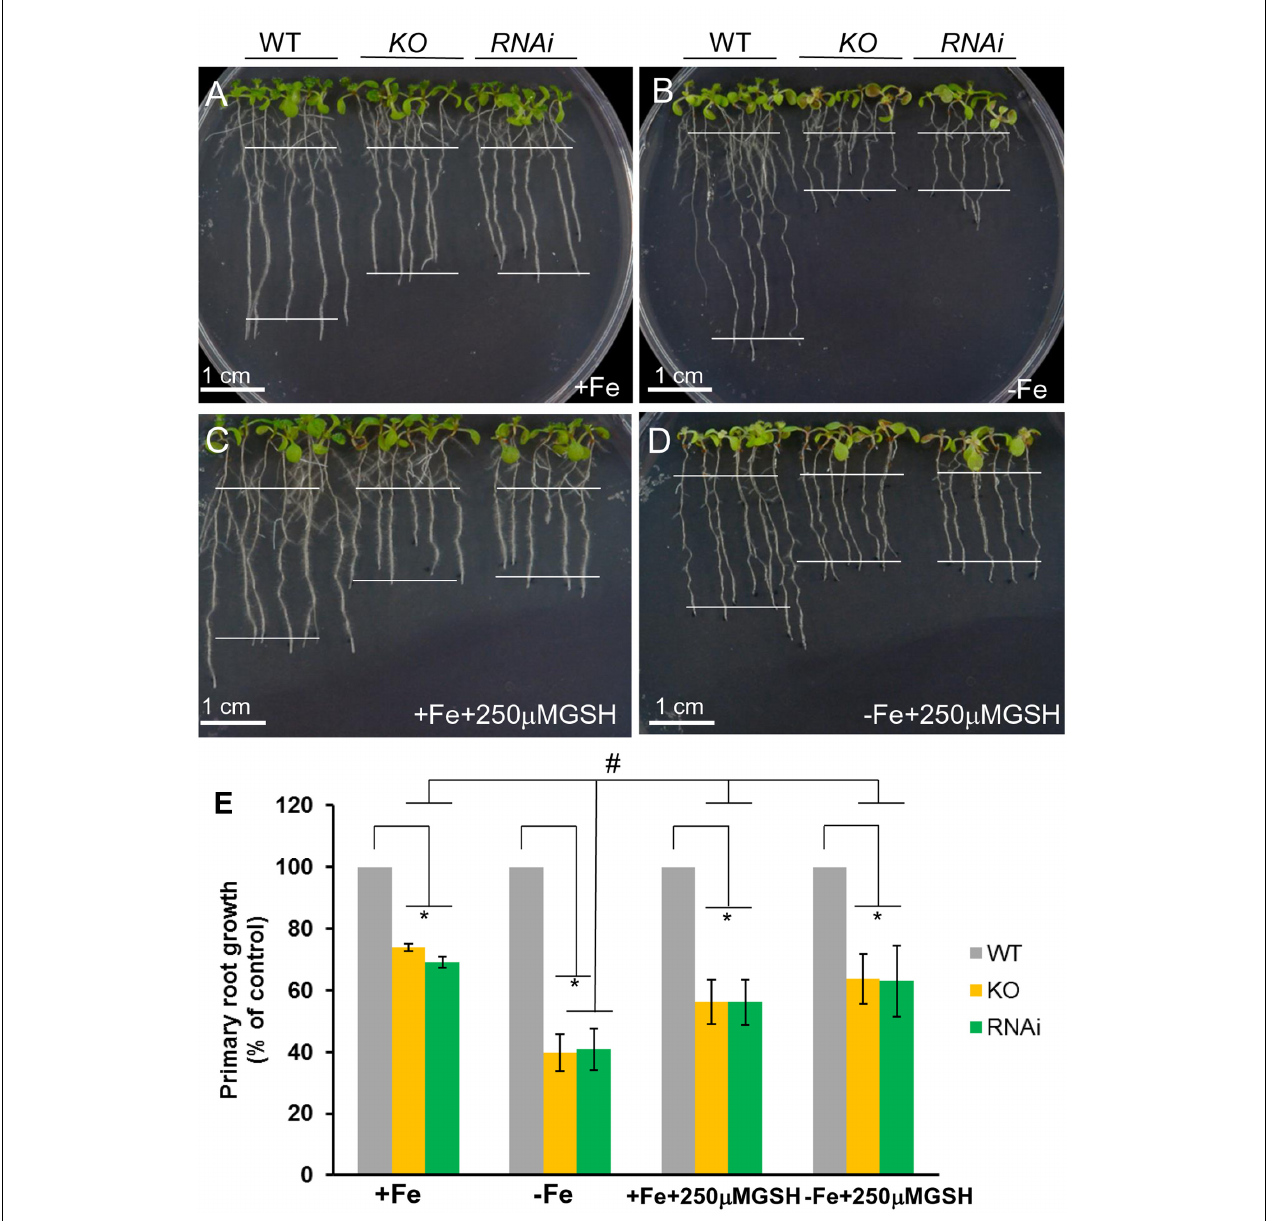
FIGURE 6 | atgrxs17 seedling sensitivities to iron deficiency stress are rescued by reduced glutathione (GSH). Wild type control, atgrxs17 KO, and AtGRXS17 RNAi seeds were germinated on 1 / 2 MS medium for 5 days and then transferred to and grown on Fe sufficient (A) or deficient (B) medium without or on Fe sufficient (C) or deficient (D) with addition of 250 µ M reduced GSH as indicated for 6 days of growth at 22 ◦ C. In (E) , primary root length was measured and the growth rate was calculated relative to wild type controls. Statistical analysis using a two-way ANOVA. n ≥ 18. ∗ p < 0.05, significance between WT controls and atgrxs17 mutants; # p < 0.05, significance between +Fe and –Fe treatments in the presence of reduced